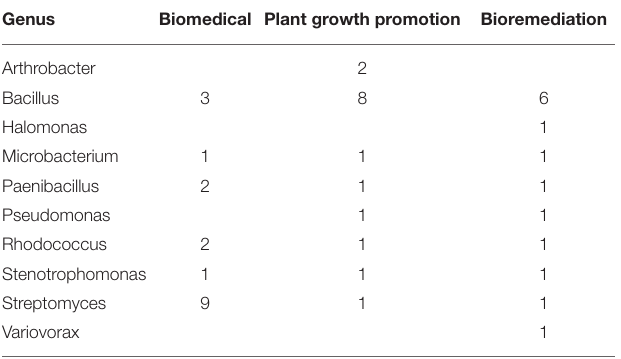
TABLE 3 | Most prevalent biotechnological capabilities among the 93 isolates according to the literature.